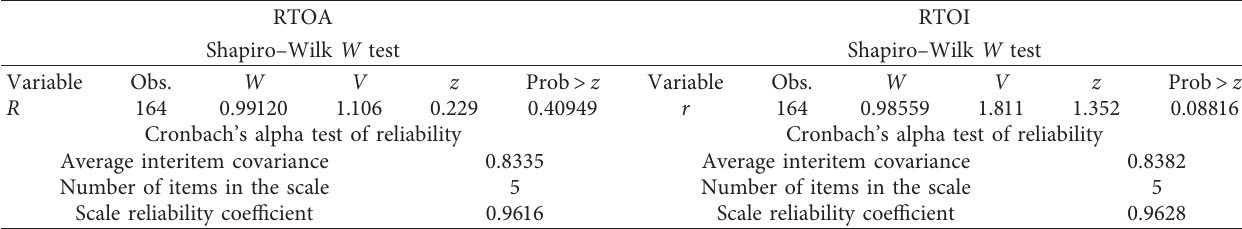
Table 2: Shapiro–Wilk W test for normal data and Cronbach’s alpha test of reliability.